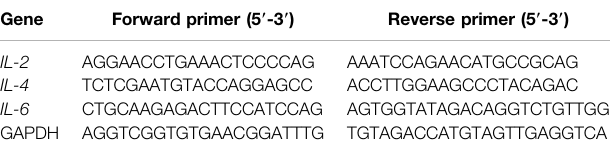
TABLE 1 | Primer sequences used for